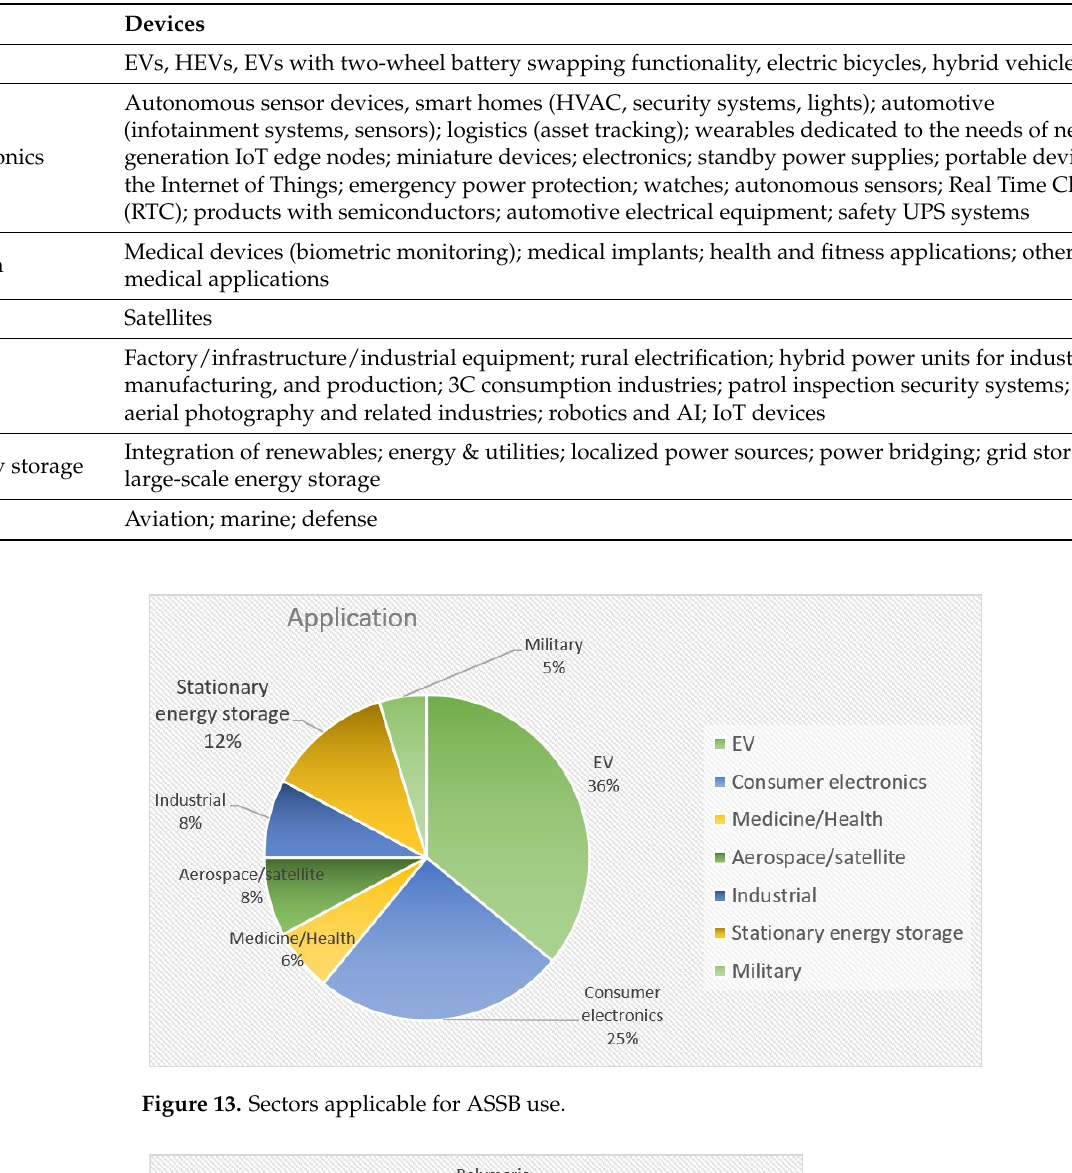
Table 4. Industrial sectors applicable for ASSB technology.